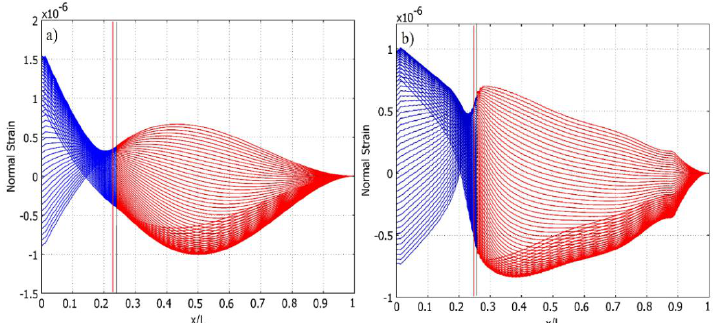
Figure 10. Normal strain distribution vs . the length of the cantilever per ½ T from transient analysis and the segmentation nodal point: ( a ) cantilever of a constant cross-section; ( b ) optimally-shaped cantilever. Vertical red line: nodal point position determined from modal analysis; black: from transient